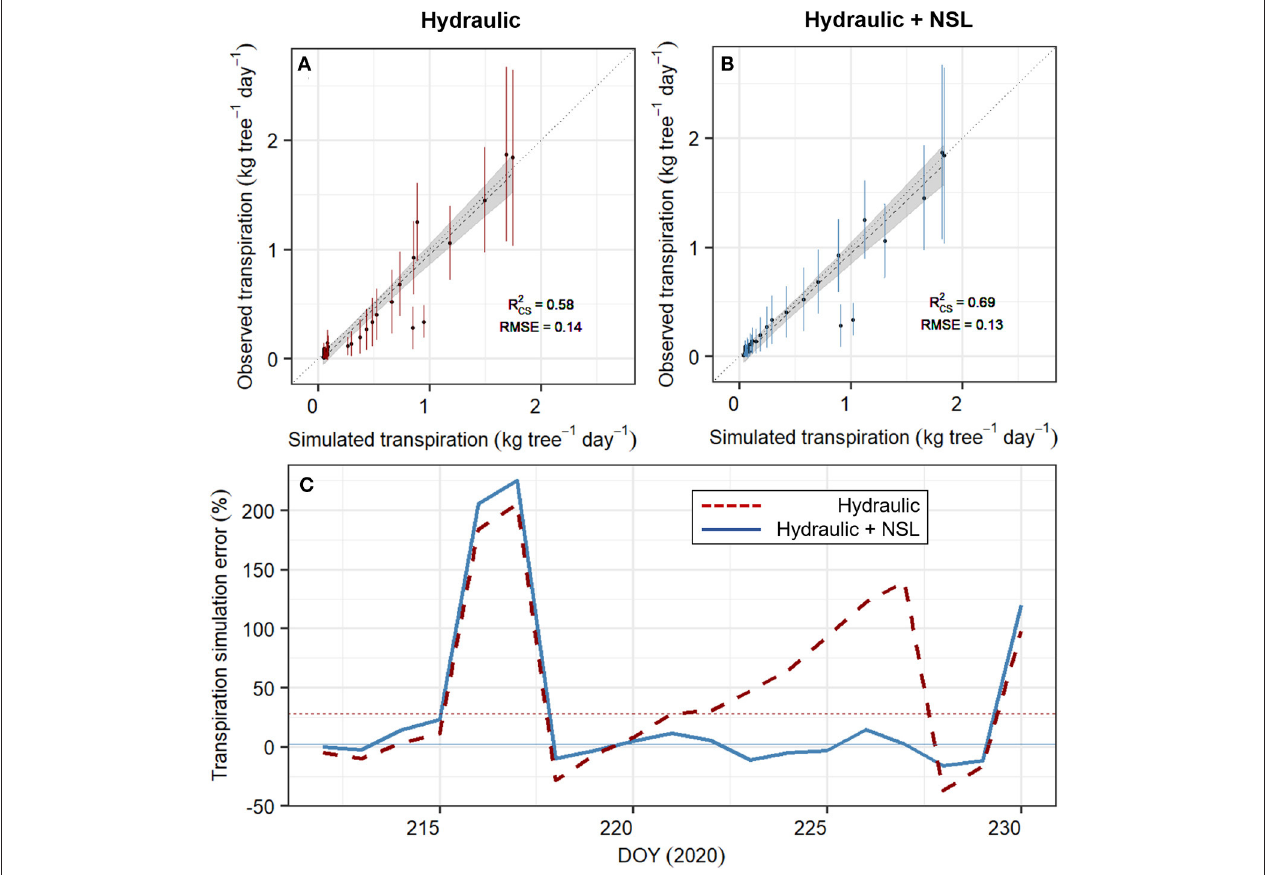
FIGURE 6 | Performance of the SOX + model calibrated without (“Hydraulic,” A , in red) and with (“Hydraulic + NSL,” B , in blue) non-stomatal limitations of photosynthesis. (A,B) show the comparison between simulated and observed transpiration (in kg tree − 1 day − 1 , points ± SD error bars), during the experiment (DOY 212–265). Daily simulated transpiration is the projected median by sampling 500 times each of the SOX + model formulation posterior parameter estimates. Noted is the generalized linear model accounting for temporal autocorrelation, model fit ( R 2 cs ), and the RMSE. In both formulations, the slope was not significantly different than 1 ( p < 0.01), and the intercept was not significantly different than 0 ( p < 0.01). (C) represents the SOX + error in transpiration estimates for the calibration period (DOY 212–230), and for the Hydraulic (red, dashed lines) and Hydraulic + NSL (blue, continuous lines) formulations. Simulation error was calculated as Tr sim − Tr obs Tr sim is the daily median transpiration from the 500 model, and Tr obs is the daily observed transpiration, both in kg tree − 1 day − 1 . Horizontal lines represent the median simulated error for each SOX +